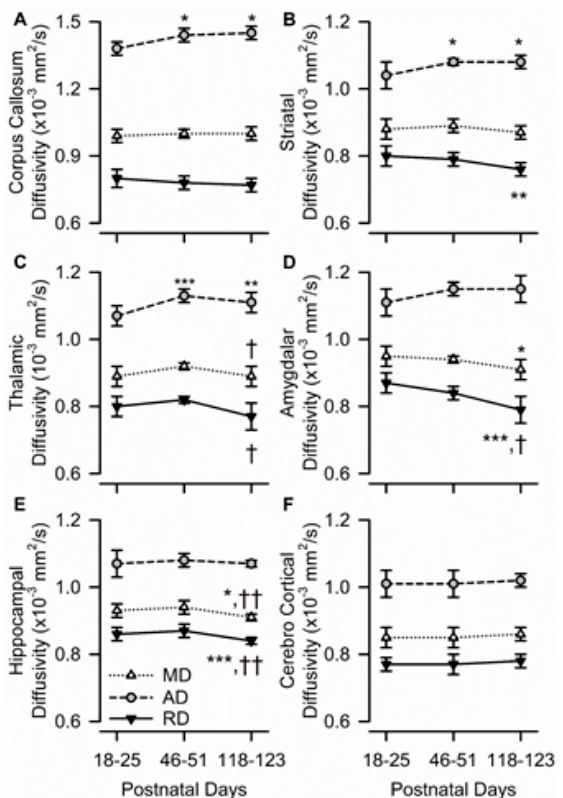
Figure 4. Age dependence of axial, radial, and mean diffusivity (AD, RD, and MD, respectively) in different ROIs of the male guinea pig brain. Graphs illustrate the age dependence of AD, RD, and MD in the corpus callosum ( A ), striatum ( B ), thalamus ( C ), amygdala ( D ), hippocampus ( E ), and cerebral cortex ( F ), in the brain of male guinea pigs. Symbols and error bars represent mean and SD of results obtained from six guinea pigs examined longitudinally at PND 18-25, PND 46-51, and PND 118-123. Whenever ANOVA revealed a significant effect of age on a given parameter, the Tukey post-hoc test was used for multi-group comparisons. Asterisks and daggers are used for comparison, with data obtained at PND 18-25 and PND 46-51, respectively. *, p < 0.05; **, p < 0.01; ***, p < 0.001; †, p < 0.05; ††, p < 0.01.